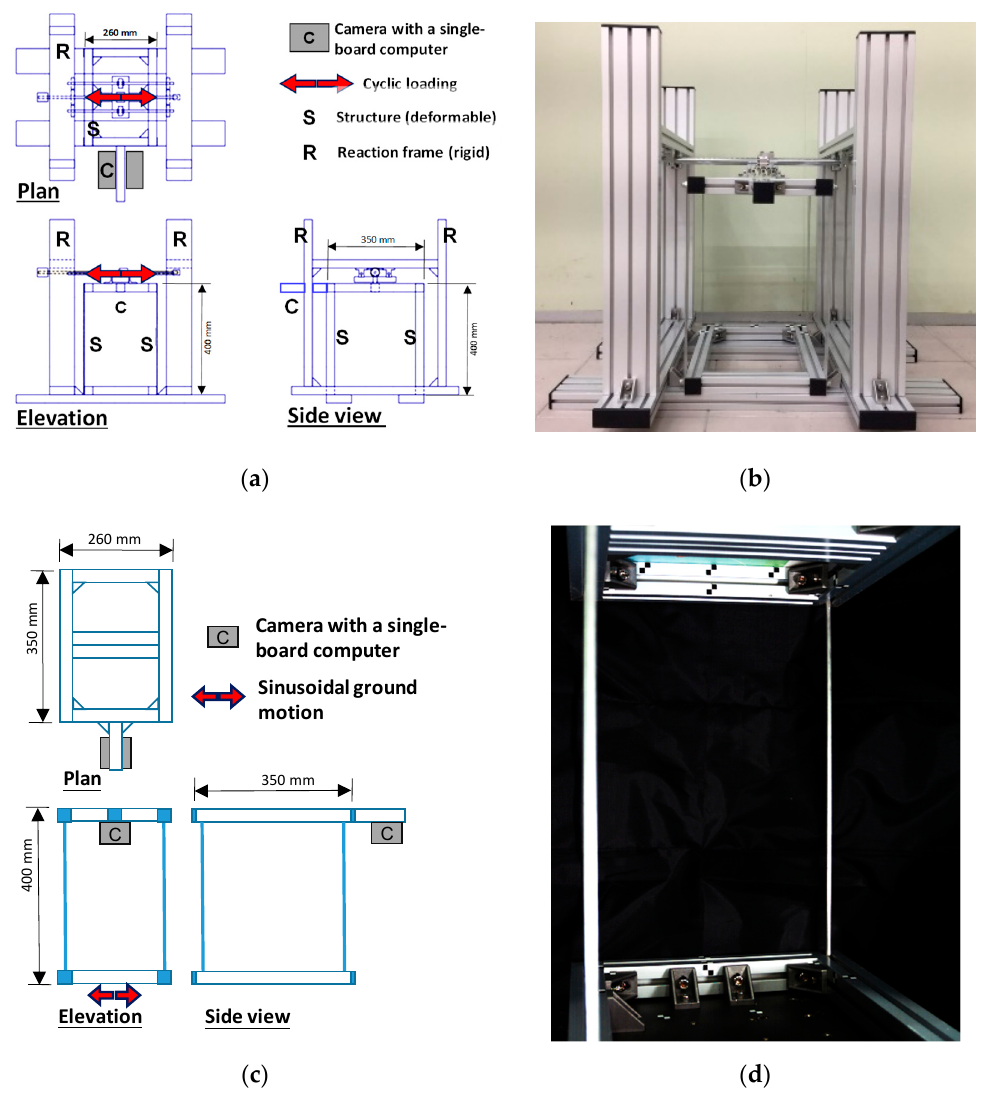
Figure 5. Structural specimens for the reduced scale static and dynamic experiments. ( a ) Design of the static experiments. ( b ) Actual configuration of the static experiments. ( c ) Design of the dynamic experiments. ( d ) Actual configuration of the dynamic experiments.